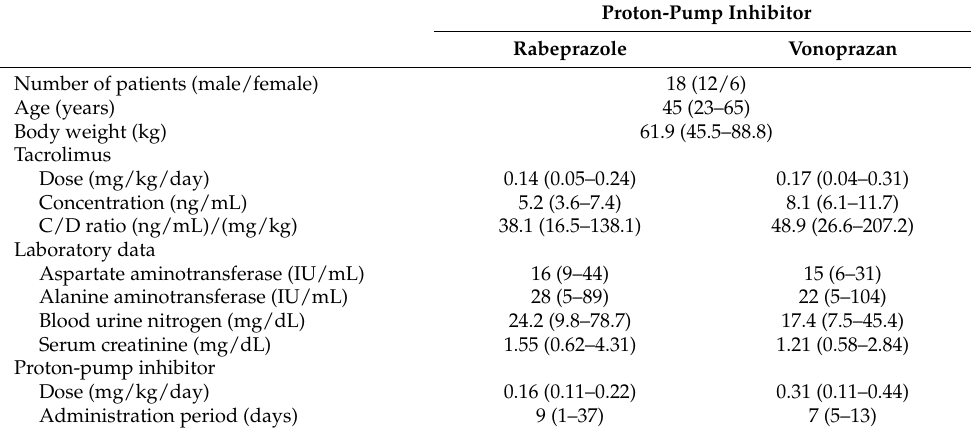
Table 1. Patient